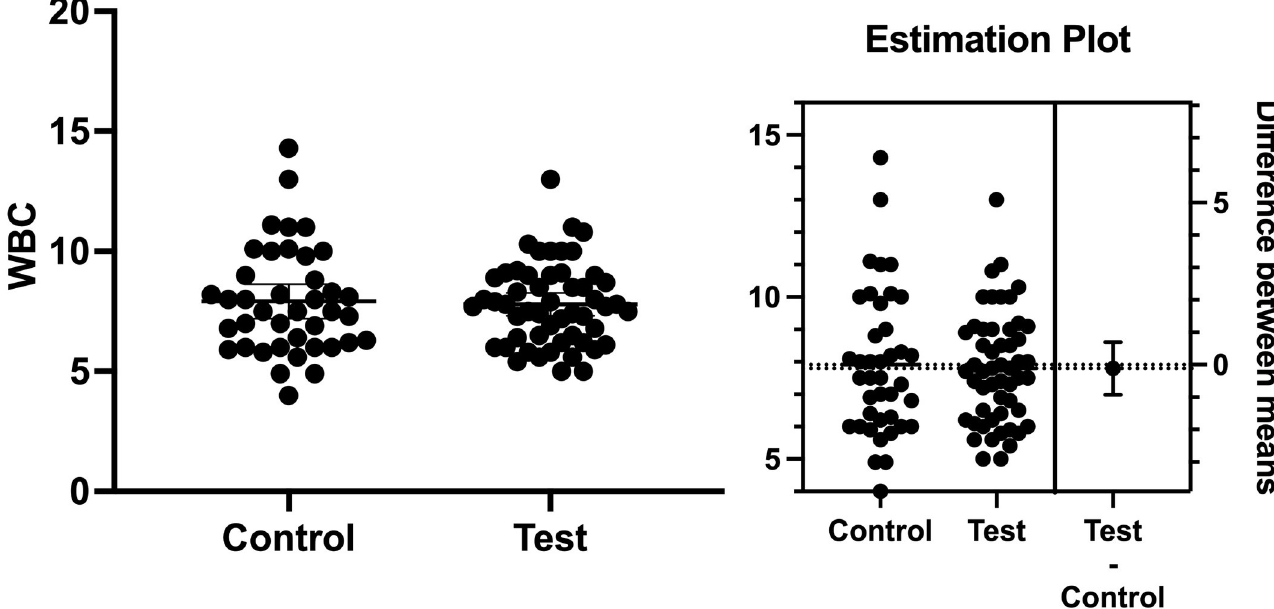
Fig 2. The number of white blood cells. The number of white blood cells (WBCs) in the test and control groups was 7.79x10 9 /L and 7.91 x10 9 /L, respectively. The mean difference between the groups was 0.12 ± 0.4 ( p = 0.76).